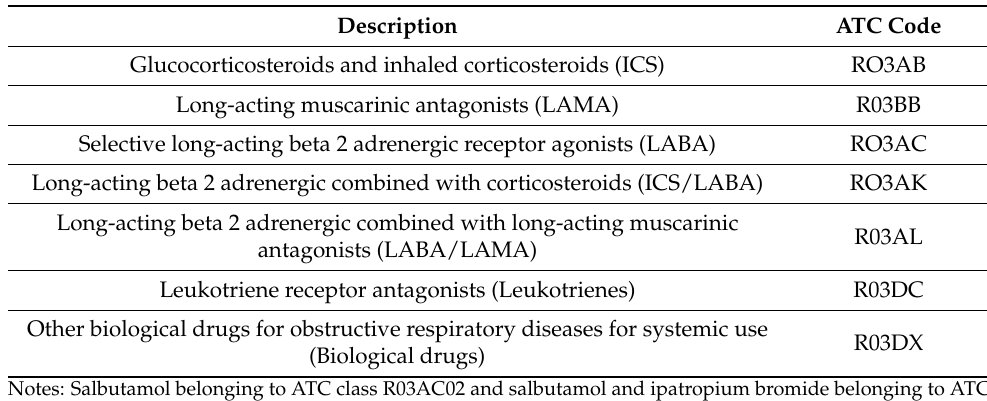
Table 1. Anatomical Therapeutic Chemical (ATC) classification system of respiratory drugs reported in the study.